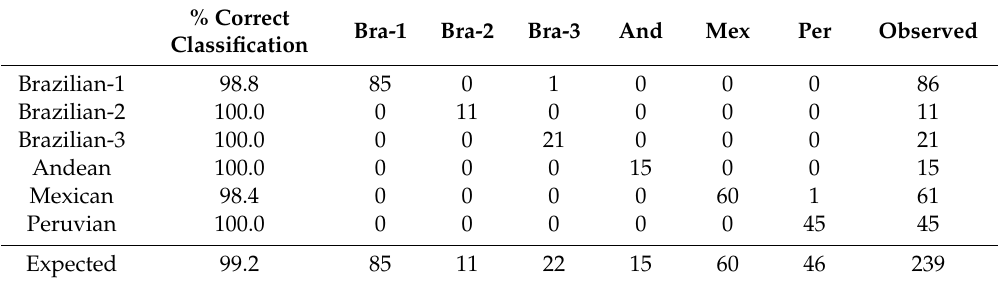
Figure 8. Centroid size of female wings. The mean centroid size (±1 SE) of female wings by morphotype of the A. fraterculus complex. Different letters mean that values have statistical significance based on Dunn’s test ( p < 0.05). Table 4. Classification matrix of individuals by morphotype according to predictive model. Observed values in the rows and the expected in the columns .